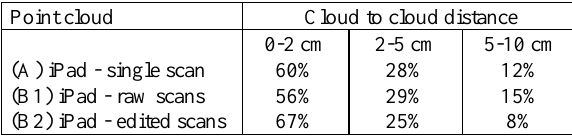
Table 7 . Evaluation of the positioning through ICP algorithm to the TLS scans by means of cloud-to-cloud distance.